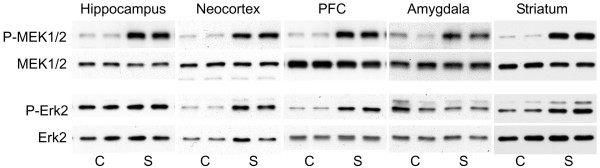
Swim stress increased phosphorylation of MEK1/2 and Erk2 in brain. Representative immunoblots of changes in P-MEK1/2 and P-Erk2 after subjecting rats to forced swim for 15 min. Total (pan) MEK1/2 and Erk2 were unchanged by swim stress. In this and all other immunoblot figures, molecular weight markers (not shown) corroborated the expected size of target proteins. C, control; S, swim stress.